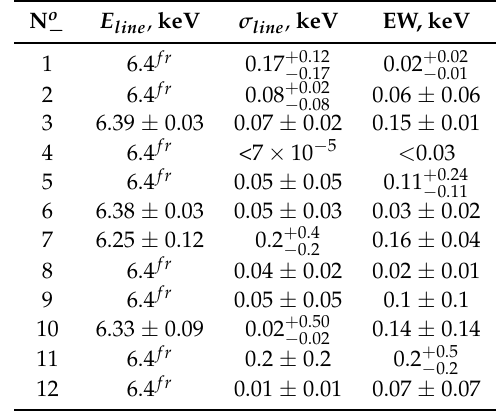
Table 2. Fe K α line emission parameters. First column: observational period; second column: line energy; third column: line width; fourth column: equivalent